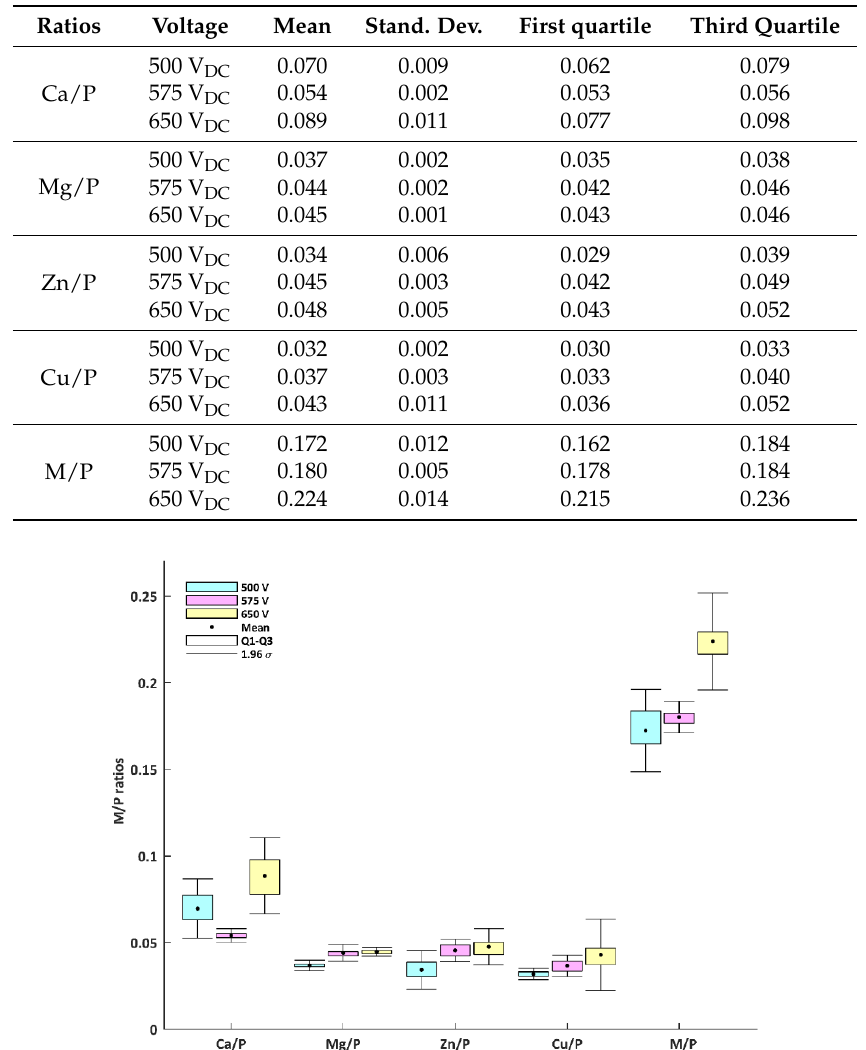
Table 3. Statistical descriptions of Ca/P, Mg/P, Zn/P, Cu/P, M/P ratios based on atomic percent (M = Ca + Mg + Zn + Cu).